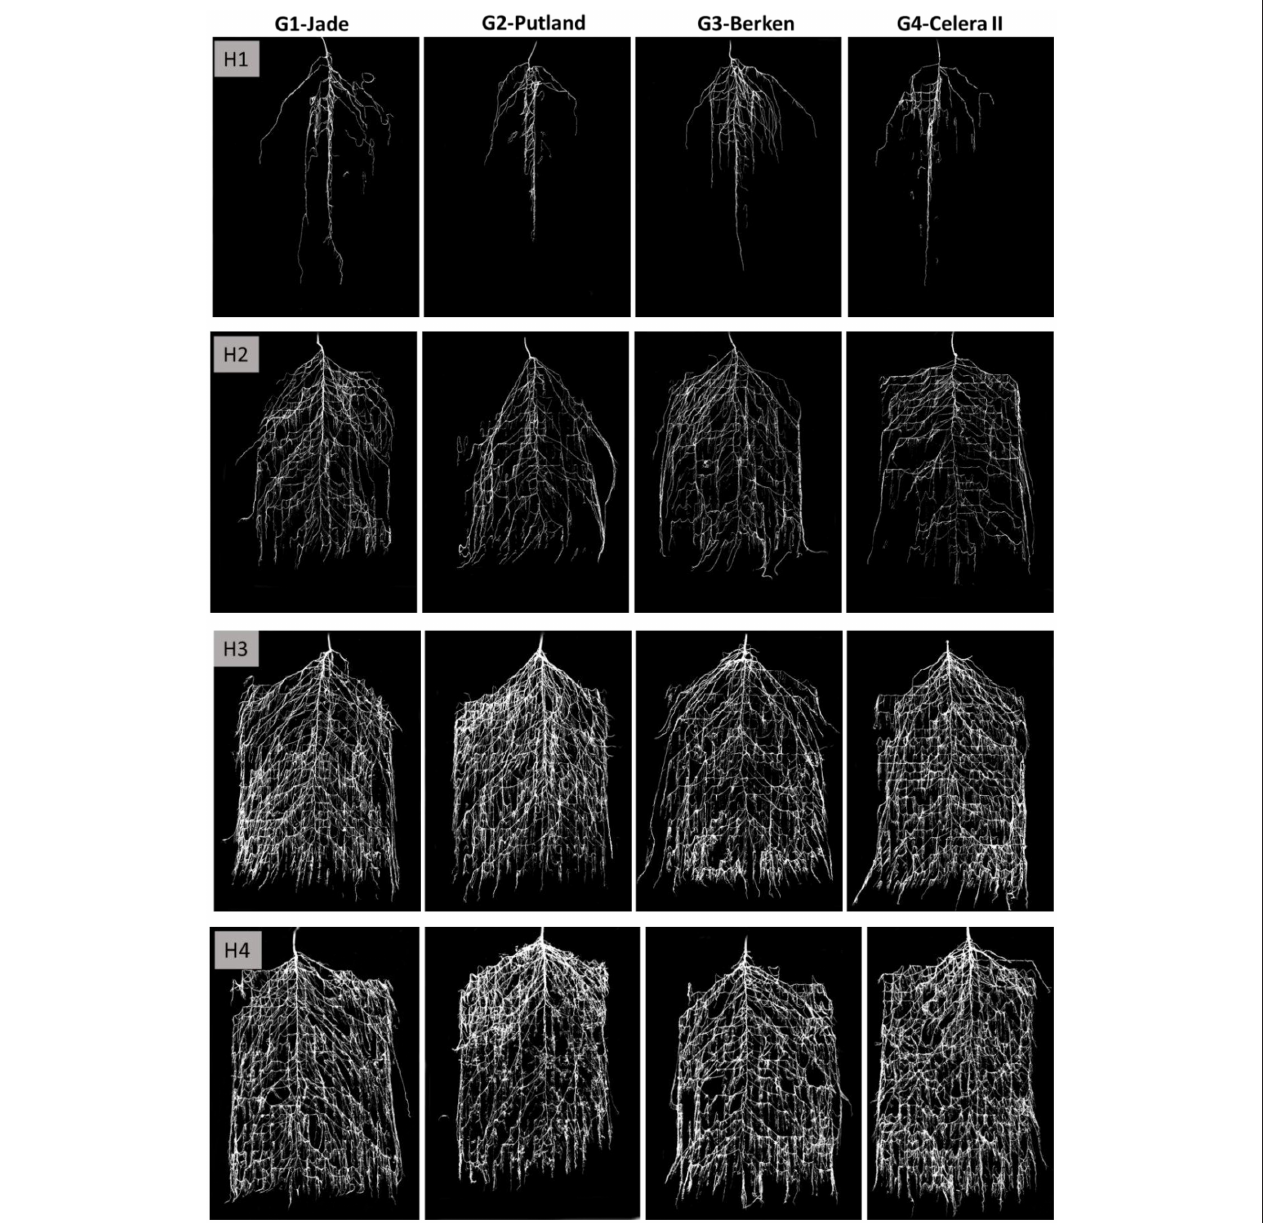
FIGURE 3 | Intact root growth images on the pinboard (after processing with adobe photoshop) at four harvests (H1, H2, H3 and H4) for mungbean varieties Jade, Putland, Berken and Celera II. These images were analyzed with WinRhizo for key root traits measurements.